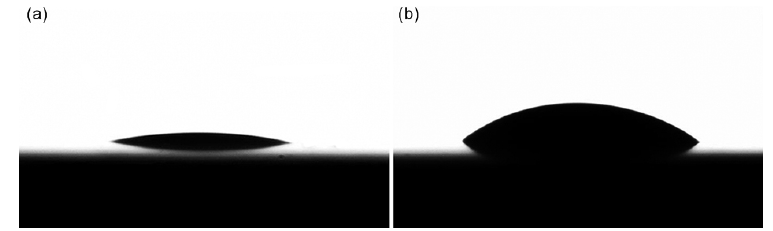
Figure 1. Drop topographies of water ( a ) and methylene iodide ( b ) formed on the dentin surfaces.